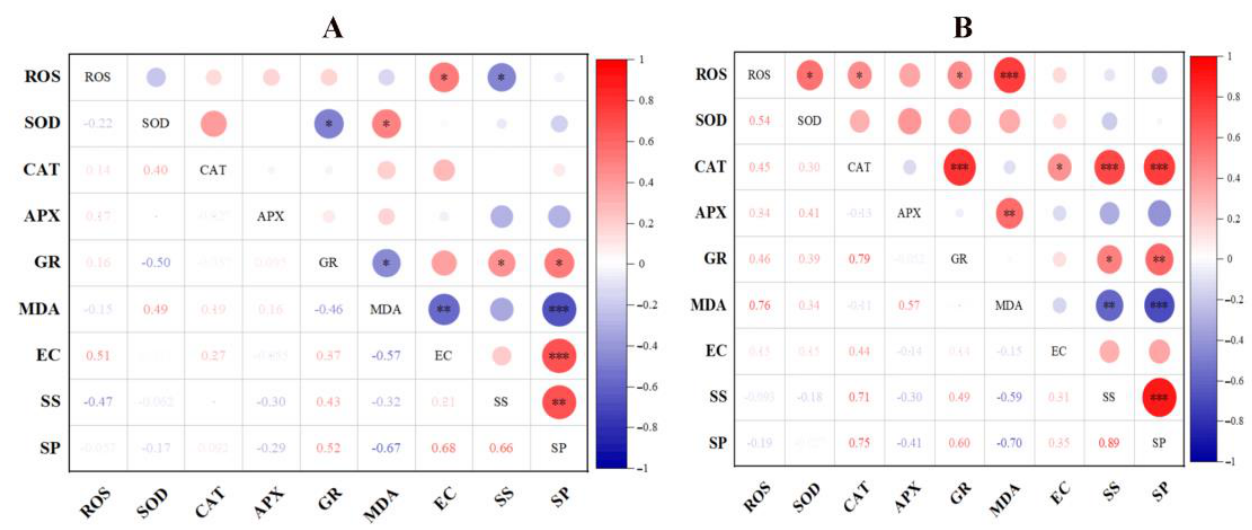
Figure 6. Correlation analysis of cell membrane integrity and ROS-metabolism-related indicators of the control ( A ) and 9% ethanol stress ( B ) groups in P. anomala NCU003 (EC: electrical conductivity; SS: soluble sugar; SP: soluble protein; *: p < 0.05; **: p < 0.05; ***: p < 0.001).